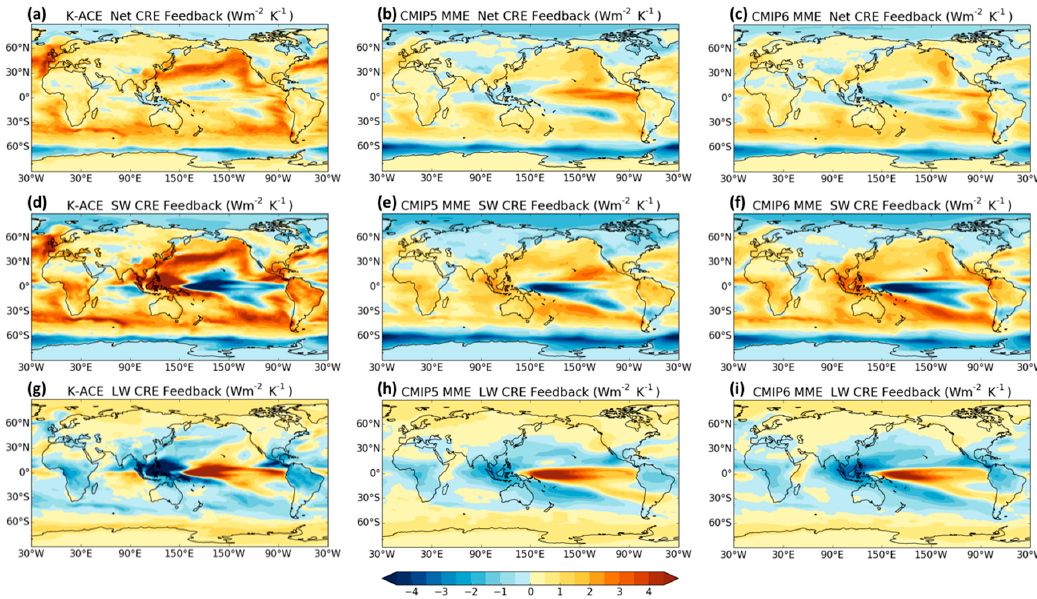
Figure 6. Global distribution of the net (first row), shortwave (SW; second row), and longwave (LW; third row) cloud radiative e ff ect (CRE) feedback components in Wm − 2 K − 1 for the K-ACE ( a , d , g third row) cloud radiative effect (CRE) feedback components in Wm − 2 K − 1 for the K-ACE ( a , d , g ), the CMIP5 ( b , e , h ), and the CMIP6 ( c , f , i ) models. These patterns are determined from the slope of the Gregory regression [48] in the abrupt experiment.